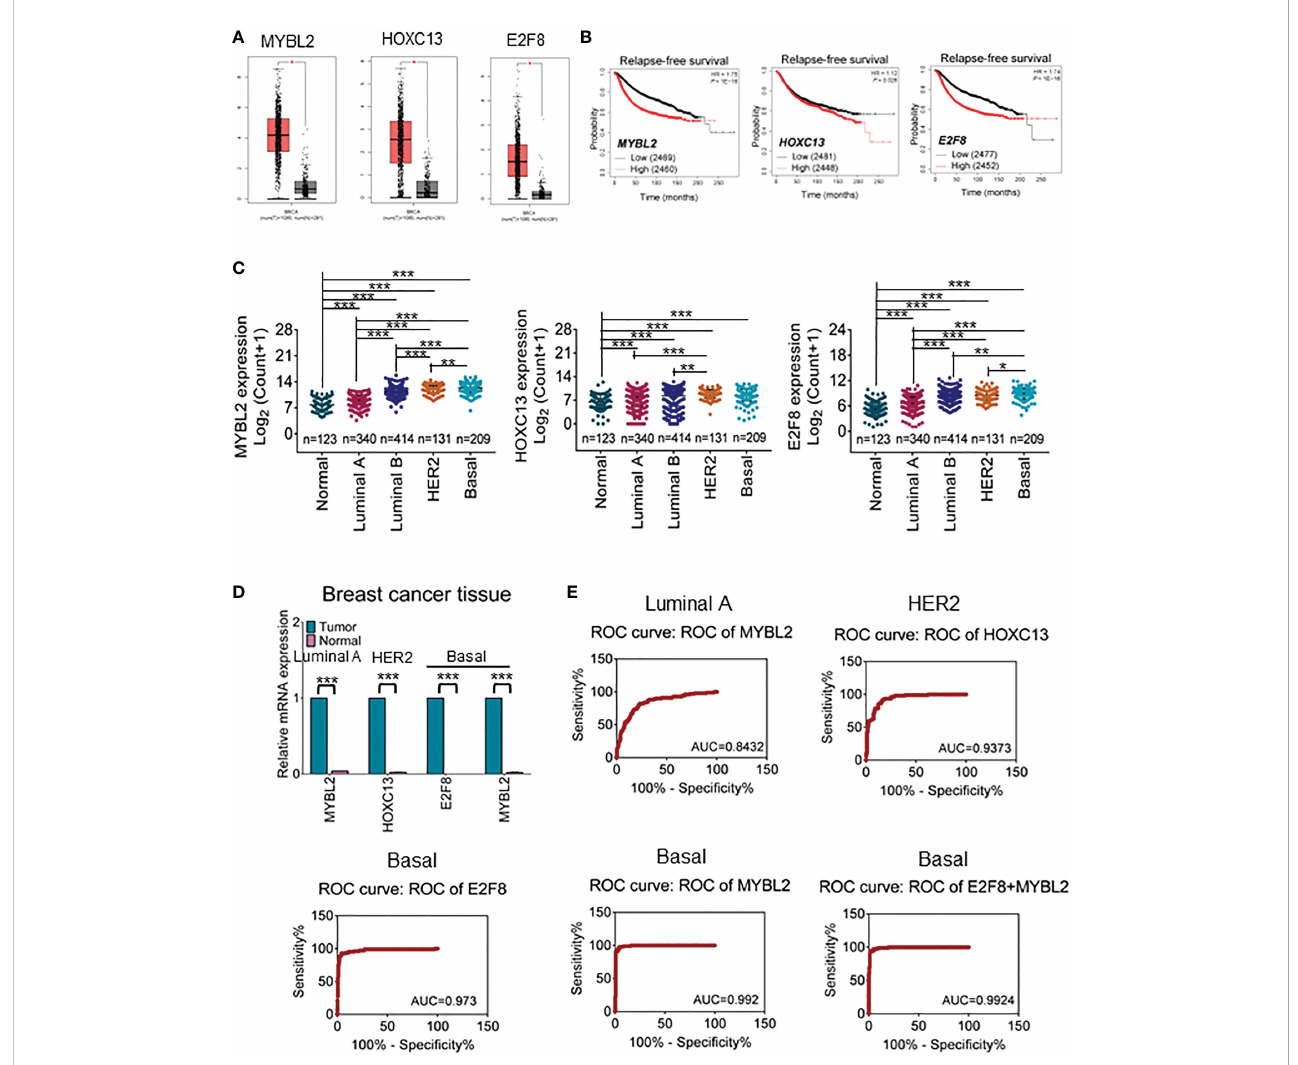
FIGURE 2 The prognosis value for upregulation of TFs in breast cancers. (A) The GEPIA dataset analysis for the expression of MYBL2, HOXC13, and E2F8 in invasive breast carcinoma. (B) The Kaplan – Meier plotter dataset analysis for relapse-free survival (RFS) of patients who had “ high ” or “ low ” expression of E2F8. (C) The expression analysis of MYBL2, HOXC13, and E2F8 in breast cancer subtypes from TCGA data based on PAM50 classi fi cation. (D) The expression of MYBL2, HOXC13, and E2F8 was veri fi ed by qRT-PCR assay in breast cancers. (E) Illustrative ROC curves for MYBL2, HOXC13, and E2F8 from TCGA data based on PAM50 classi fi cation of breast cancers (* p < 0.05; ** p < 0.01; *** p <